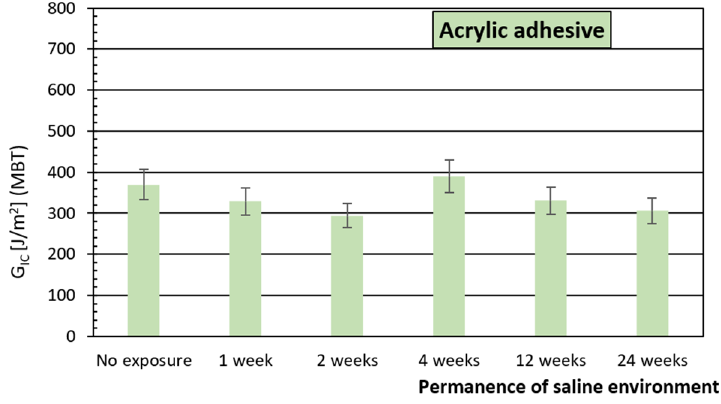
Figure 8. Energy release rate evolution under mode I of acrylic adhesive saline stress.